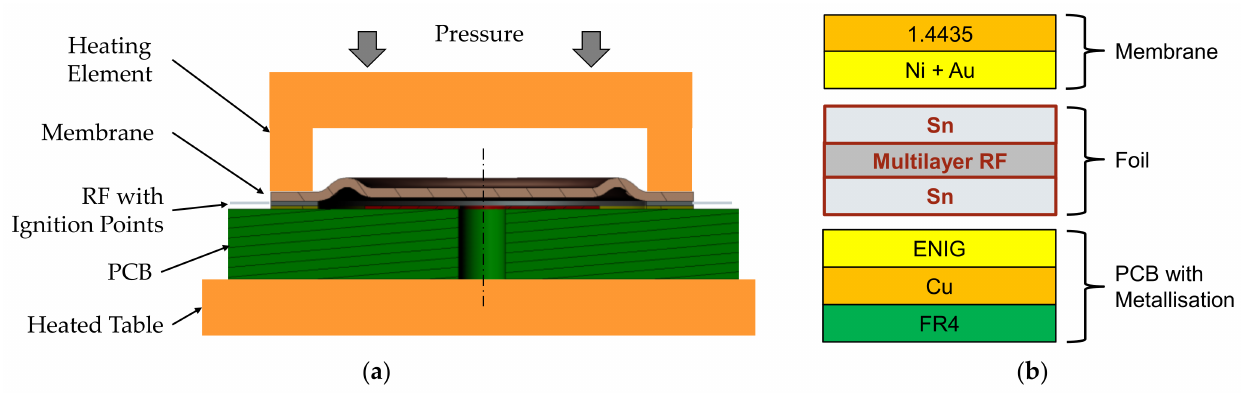
Figure 7. Reactive joining process: ( a ) cross-section sketch of the equipment; ( b ) cross-section sketch of the layer